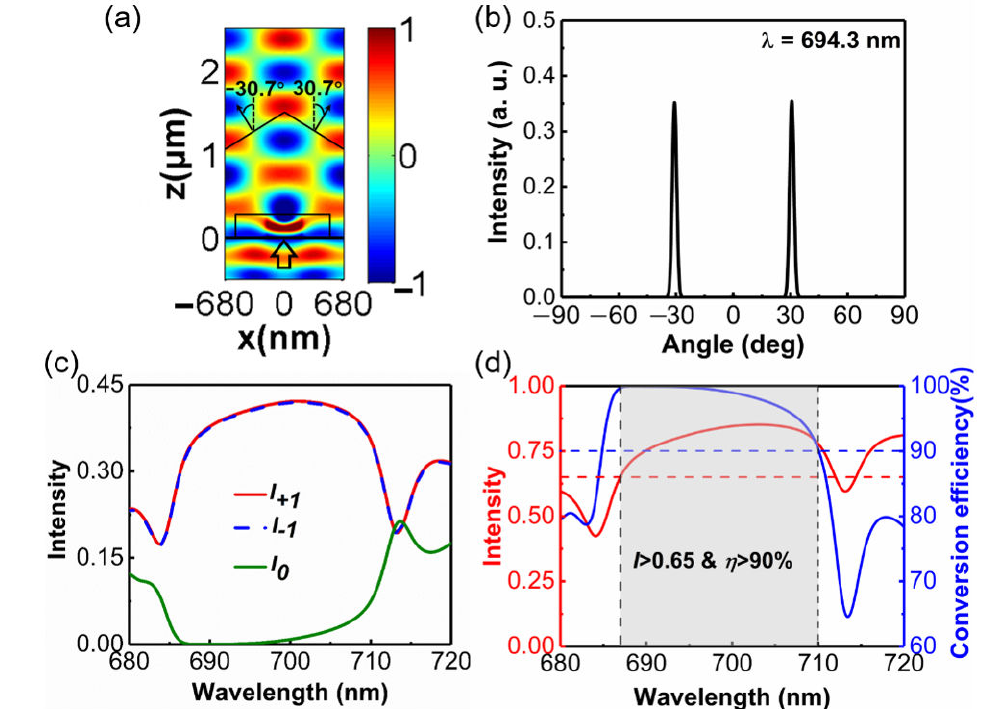
Figure 7. ( a ) Ey field pattern in the x-z plane under y-polarized normal incidence at a wavelength of 694.3 nm. ( b ) Normalized far-field intensity distributions of the transmitted beams. ( c ) Intensity of +1, 0, and − 1 diffraction orders within the wavelength region from 680 nm to 720 nm. ( d ) Transmission intensity and conversion efficiency of the transmitted beam for y-polarized incidence in the wave range from 680 nm to 720 nm. The red dashed line indicates that the transmission is 0.65, the blue dashed line represents the conversion efficiency is 90%. The transmitted angle is defined as the positive (negative) value in the right (left) side of the